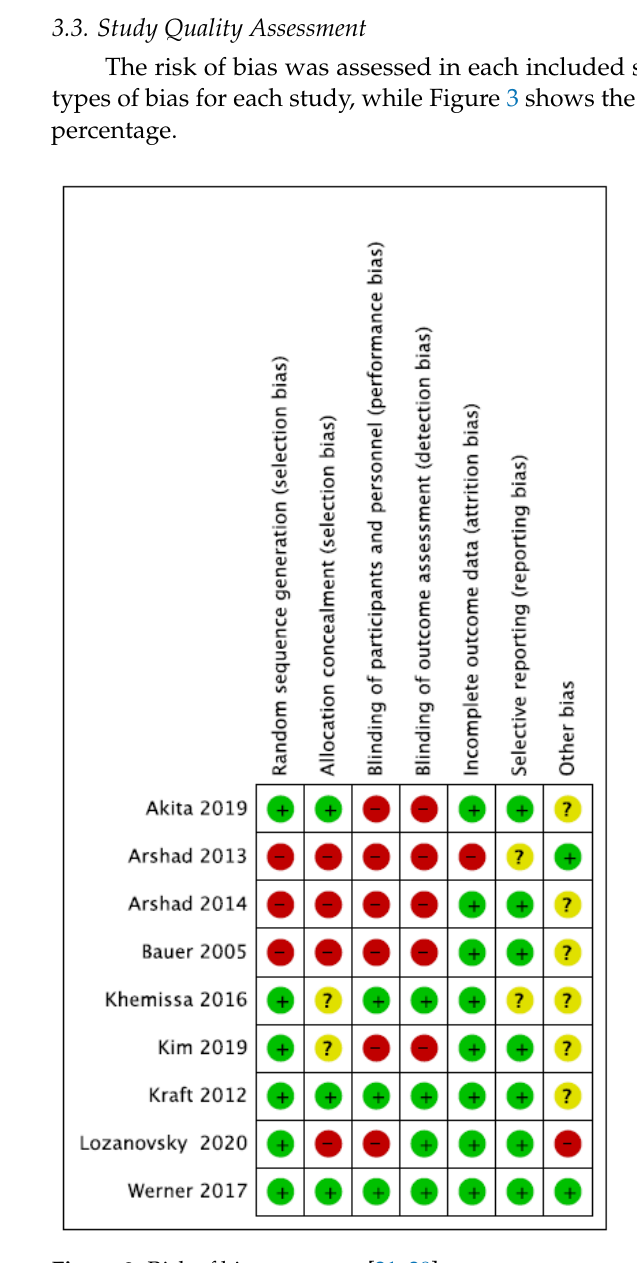
Figure 2. Risk of bias summary [21 – 29].